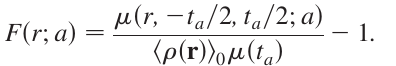
is (cid:9) ð r; (cid:1) t a = 2 ; t a = 2; a Þ (cid:1) (cid:8)(cid:9) ð t a Þ . This function oscillates